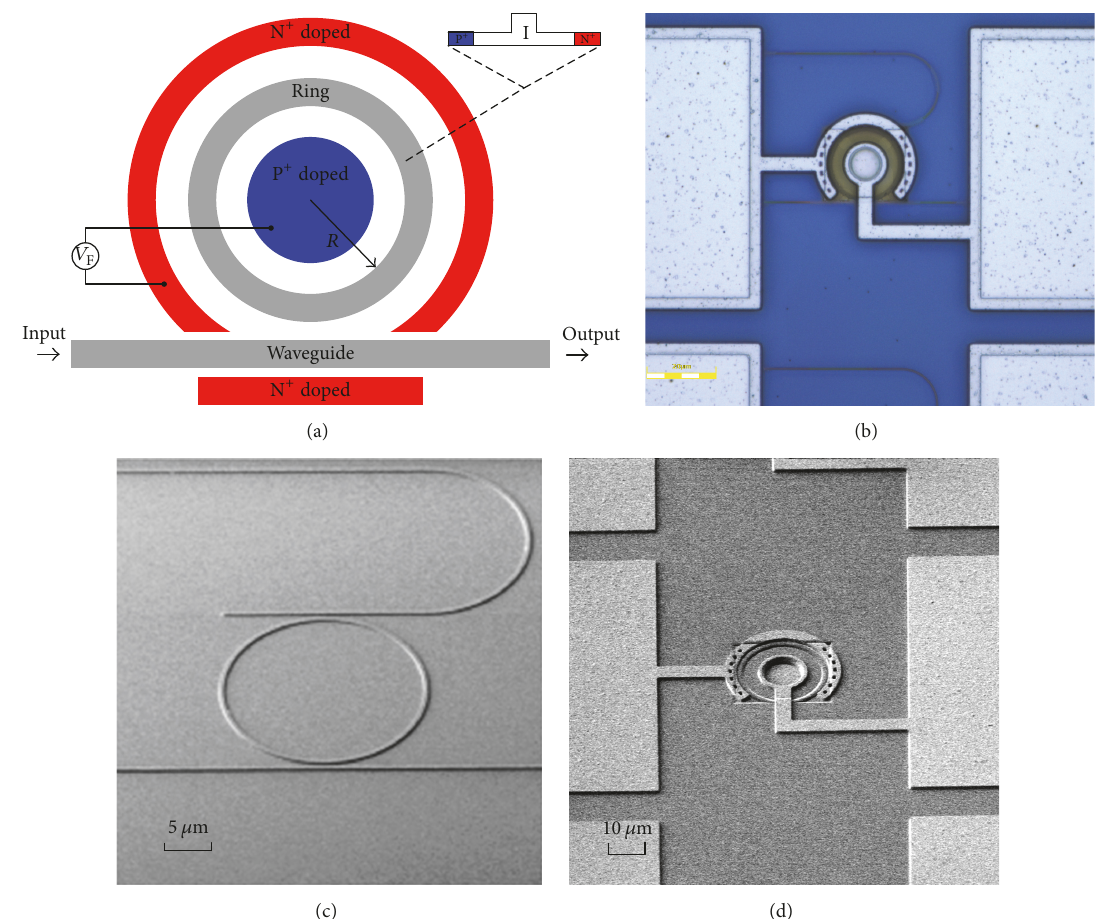
Figure 7: (a) Schematic diagram of device, (b) LSCM of device, (c) SEM of micro-ring structure, and (d) SEM of device.